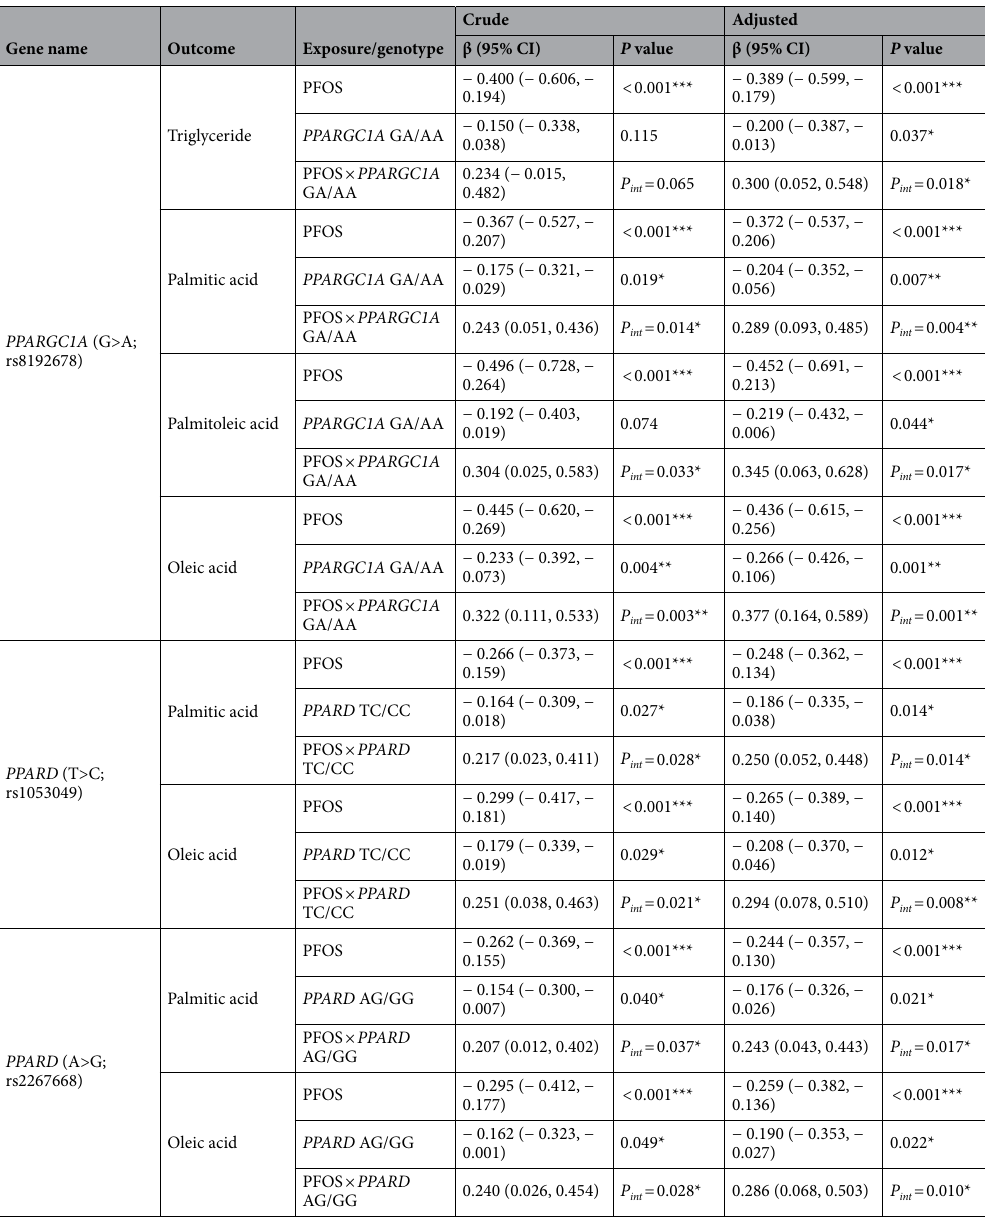
Table 3. Association between maternal perfluorooctanesulfonate levels (log 10 scales) and their genotypes of encoded genes in receptors on maternal triglyceride or fatty acid levels during pregnancy (log 10 scales) (relevant only). CI, confidence interval; FA, fatty acid; PFOS, perfluorooctanesulfonate; PPARD, peroxisome proliferator-activated receptor delta; PPARGC1A, peroxisome proliferator-activated receptor gamma co-activator 1-alpha. Association between PFOS and any FA levels were tested in multiple linear regression models. Crude: Non-adjusted. Adjusted: Adjusted for maternal age (years; continuous), maternal smoking during the 3rd trimester (yes/no), maternal alcohol consumption during pregnancy (yes/no), annual household income (< 5/ ≥ 5 million Japanese Yen), parity (primiparous/multiparous), and sampling period (gestational days; continuous). β (95% CI) represents change in log 10 -transformed levels of triglyceride (mg/100 mL), palmitic acid (μg/mL), palmitoleic acid (μg/mL), or oleic acid (μg/mL) for each tenfold increase in PFOS levels (ng/mL). P int represents P value for interaction. * P < 0.05; ** P < 0.01; *** P <